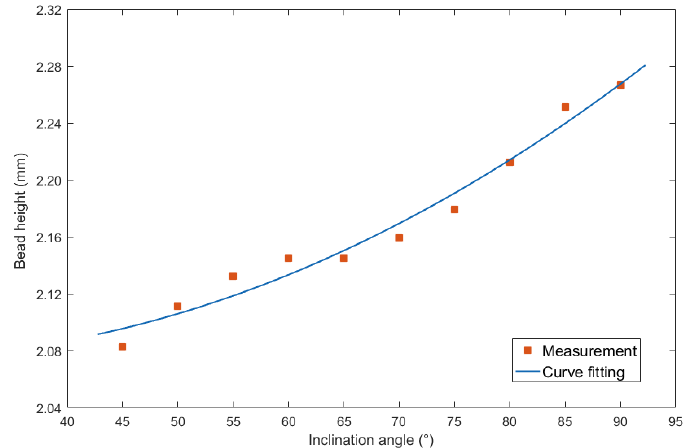
Figure 9. Curve fitting between forward inclination angle and bead height.